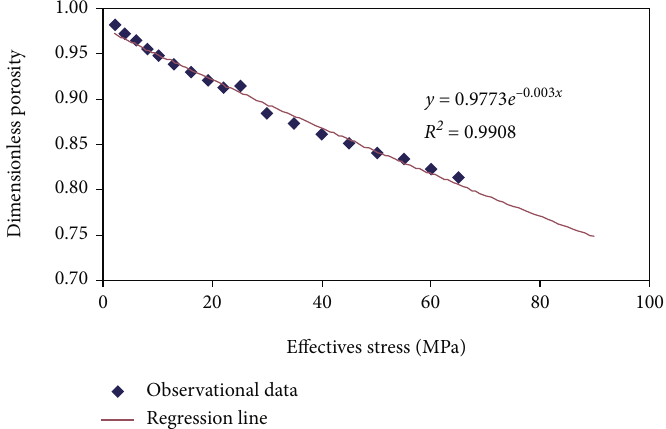
Figure 7: Relationship between dimensionless porosity and e ff ective stress.